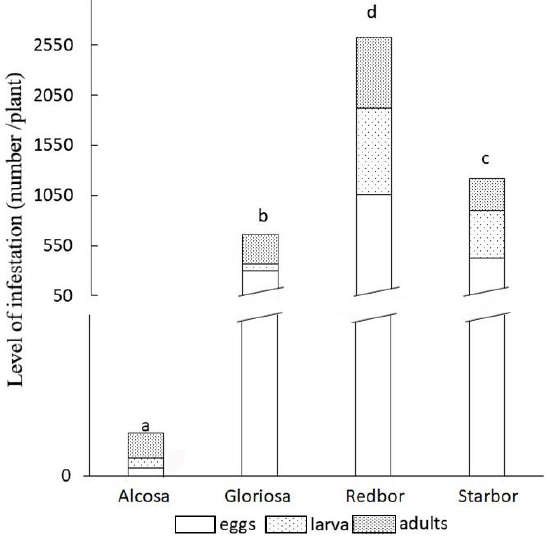
Figure 1. Infestation of kale and savoy cabbage cultivars with cabbage whitefly analyzed by one way analysis of variance (one-way ANOVA followed by Newman-Keuls test: p < 0.05). Means (all developmental stages together) with the same letter are not significantly different.